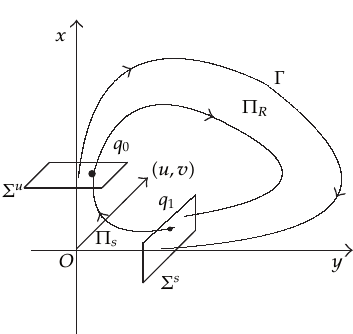
Figure 2: Setup of cross sections and Poincar´e